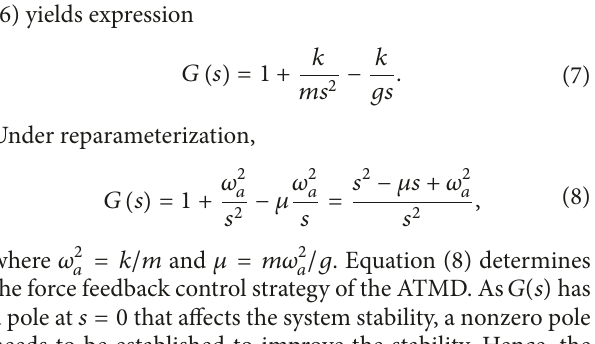
Figure 1: Schematic of the ATMD